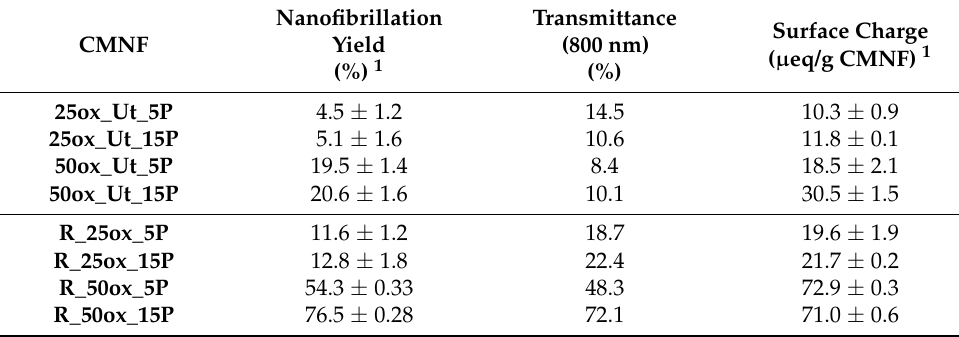
Table 2. Nanofibrillation yield, transmittance and surface charge of